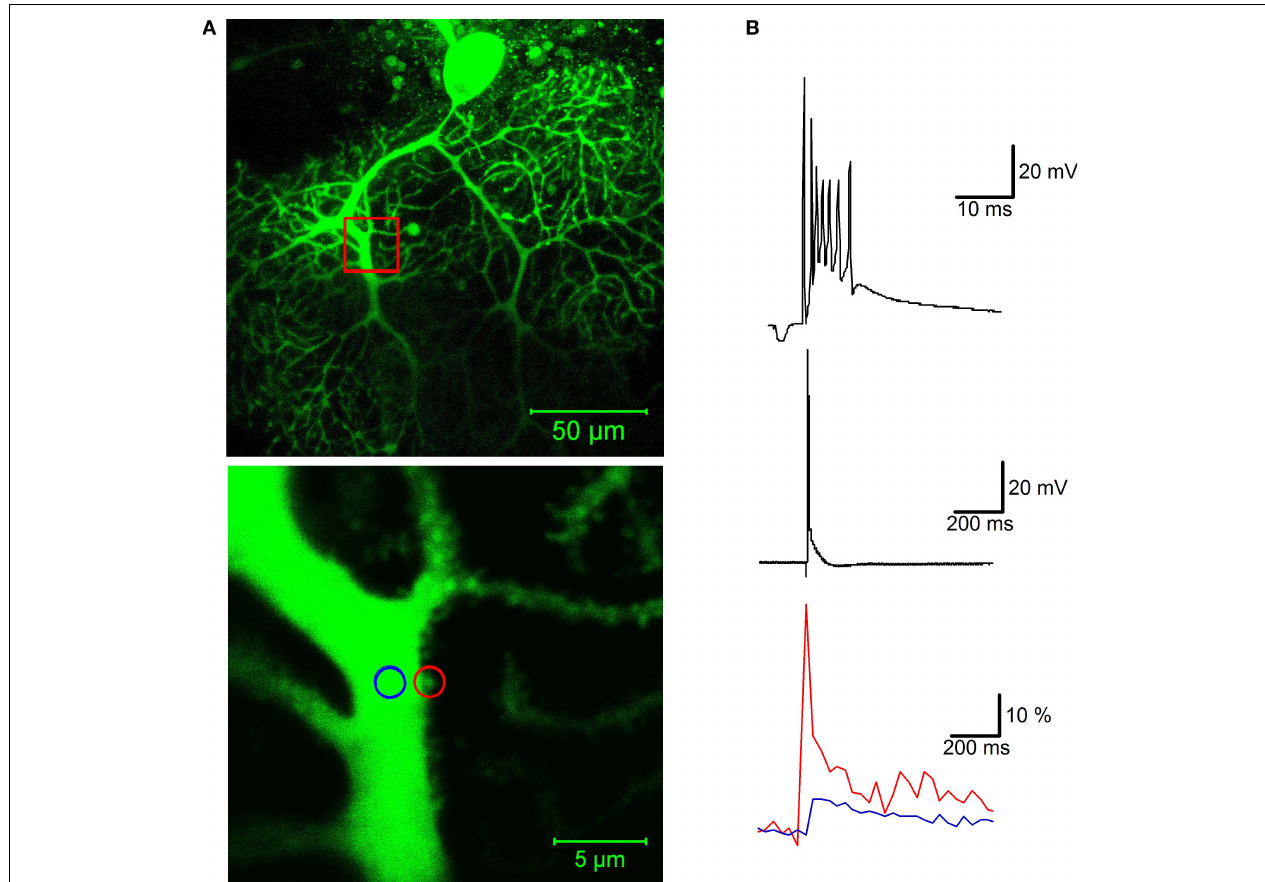
FIGURE 2 | Calcium signaling in a dendritic spine evoked by climbing fi ber activity. (A) Top: A rat Purkinje cell (P36) was fi lled through the patch pipette with the fl uorescent calcium indicator Oregon Green BAPTA-2 (200 µM). The red box indicates the magnifi cation area. Calcium transients were recorded in a spine (red circle) and in the shaft (blue circle) of the primary dendrite using a Zeiss LSM 5 Exciter confocal microscope and a × 63 Zeiss Apochromat objective (bottom picture). (B) Climbing fi ber stimulation evokes a complex